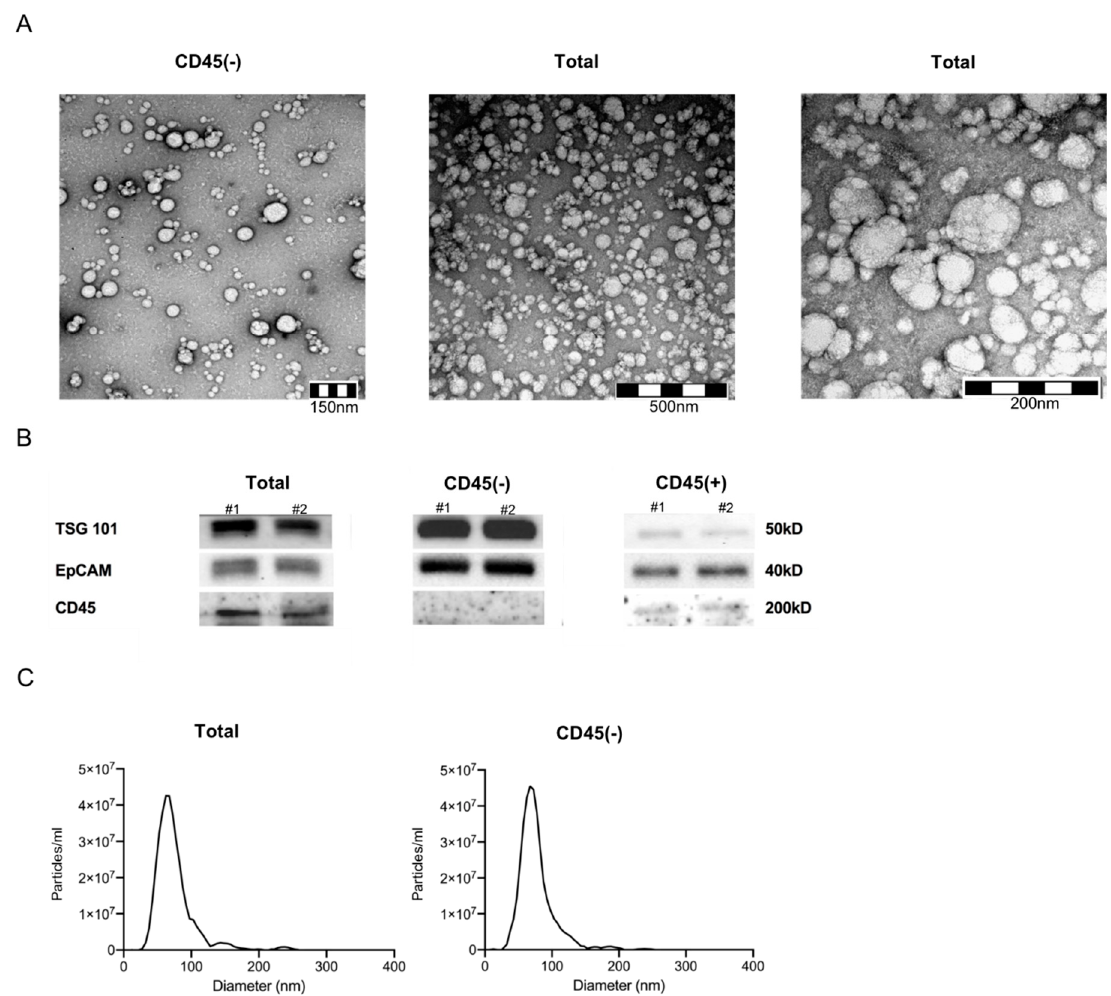
Figure 1. Exosome characterization. ( A ) Representative transmission electron microscopy pictures of CD45( − ) (left) and total (middle and right) exosomes. ( B ) Western blot for detection of TSG 101, EpCAM and CD45 of total, CD45( − ) and ( + ) exosomes from plasma of head and neck squamous cell carcinoma (HNSCC) patients (#1&2 high stage). Note that no CD45 signal was detected when using CD45( − ) exosomes. Uncropped Western blots can be found at Figure S1. ( C ) Nanoparticle tracking analysis with ZetaView of total (left) and CD45( − ) exosomes (right). Vesicles between 30 and 200 nm diameter were detected.